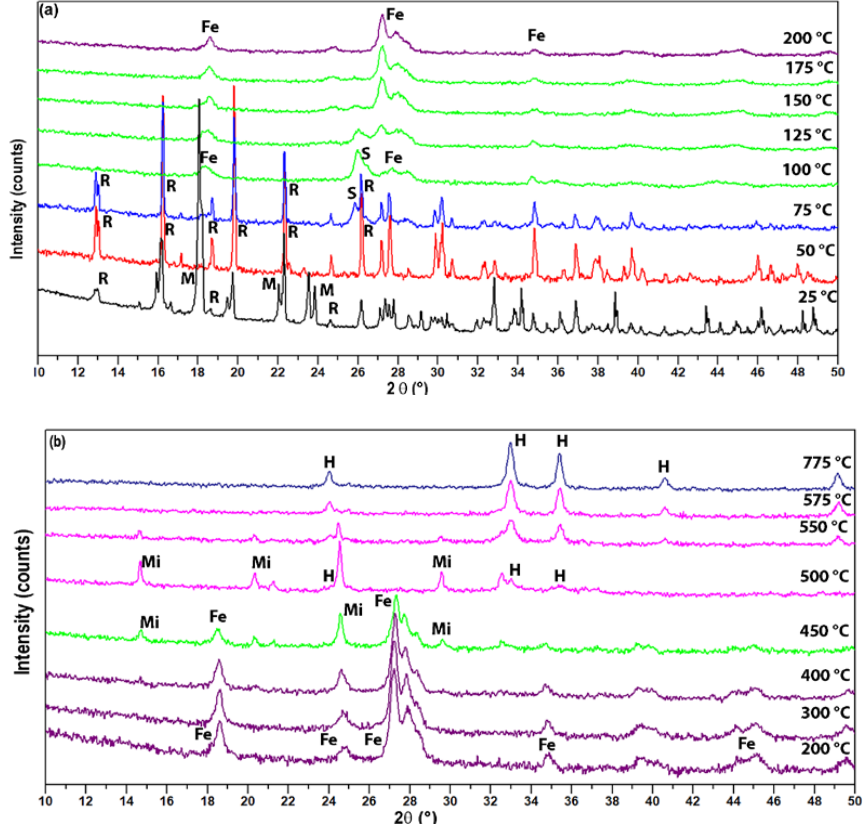
Figure 2. Selected XRPD patterns of the melanterite under study, showing the evolution of the diffraction data in the temperature range 25–200 °C ( a ) and 200–775 °C ( b ), in the 10–50° 2 θ . Labels: M = melanterite, FeSO 4 ·7H 2 O; R = rozenite, FeSO 4 ·4H 2 O; S = szomolnokite, FeSO 4 ·H 2 O; Fe = FeOHSO 4 ; Mi = mikasaite, Fe 2 (SO 4 ) 3 ; H = hematite, Fe 2 O 3 . The room temperature pattern matches that given for melanterite in the ICSD da- tabase (no. 98-001-6589), although also peaks from rozenite (no. 98-001-5914) can be identified. Rozenite does not occur in the Fornovolasco mine [11,27,28]. Therefore, the partial replacement of melanterite by rozenite resulted from the room temperature pat- tern may be ascribed to grinding of the sample. The characteristic peaks of rozenite in- crease in intensity on heating and remain clearly visible until 75 °C. Starting from 100 °C, the patterns change as a consequence of the appearance of additional phases, specifically szomolnokite and FeOHSO 4 (Figure 2a). The latter is the only phase identified in the pattern collected at 200 °C. A slight increase in the peak intensity is observed in the dif-